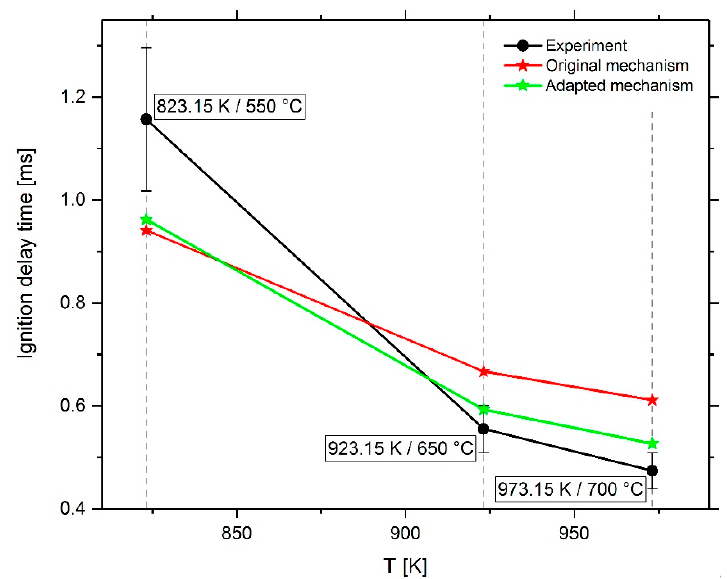
Figure 30. Comparison of measurement and CFD-simulation results using the mechanism before and after the optimization process.